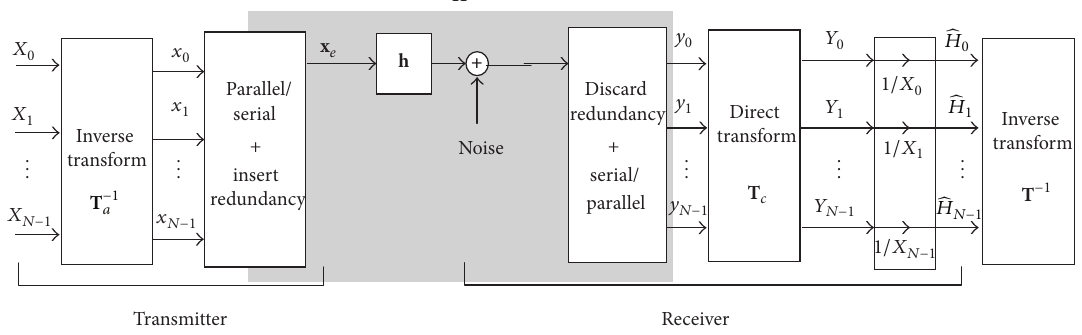
Figure 1: Block diagram of a multicarrier modulation communications system, including the channel estimation in the